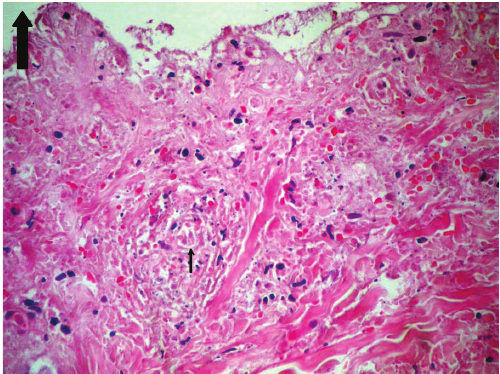
Figure 1: Palpable purpura and hemorrhagic bullae on both lower extremities.